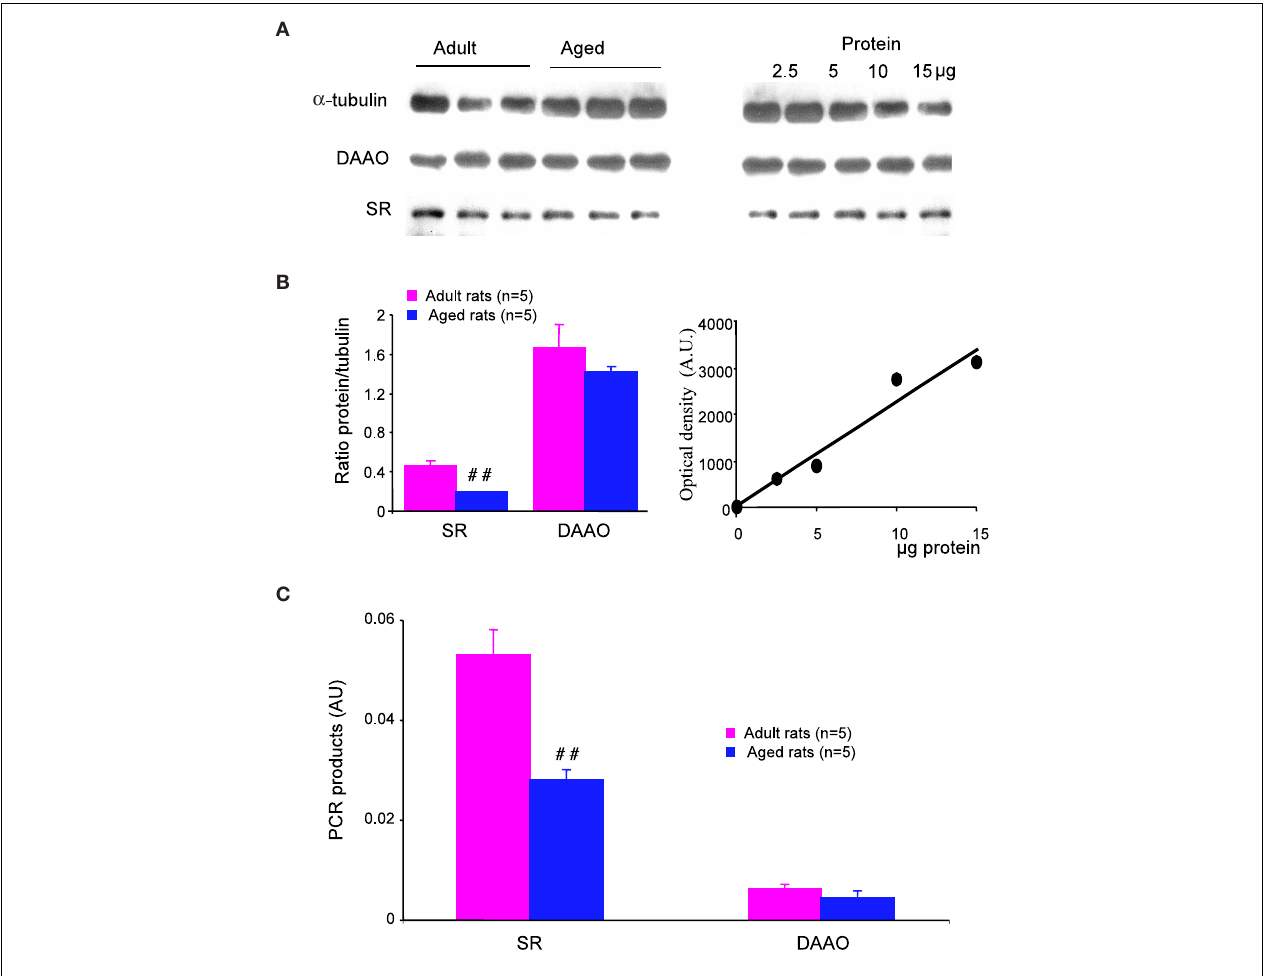
Quantitative analysis of immunoreactivity for serine racemase and D AAO in adult and aged rats, normalized to α -tubulin. ( B , right) Graph illustrating the linear relationship between optical density and the amount of protein loaded. (C) Bar graphs of mRNA levels of serine racemase and D AAO normalized to GFAP transcripts in adult and aged rats (## p < 0.01, unpaired t -test). AU, arbitrary